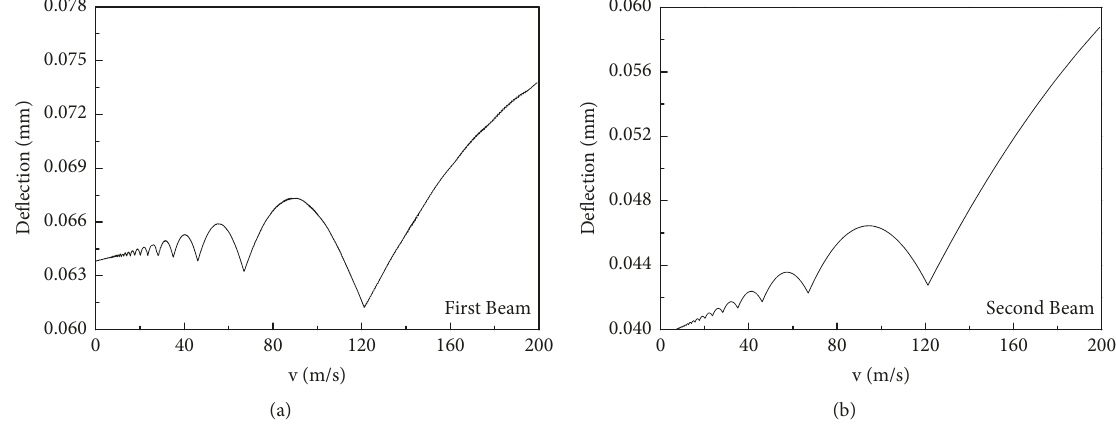
Figure 9: Relationship between maximum deflection and loading speed for mid-span of double simply supported beam with first beam’s moment of inertia taking as 10 5 I 1 : (a) first beam; (b) second beam.